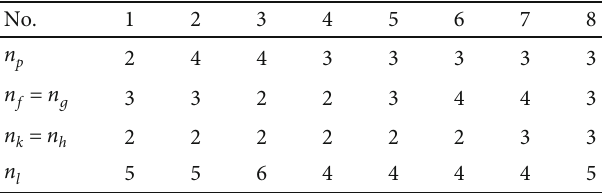
Table 6: Term setting of the Tempel-1 rendezvous trajectory.